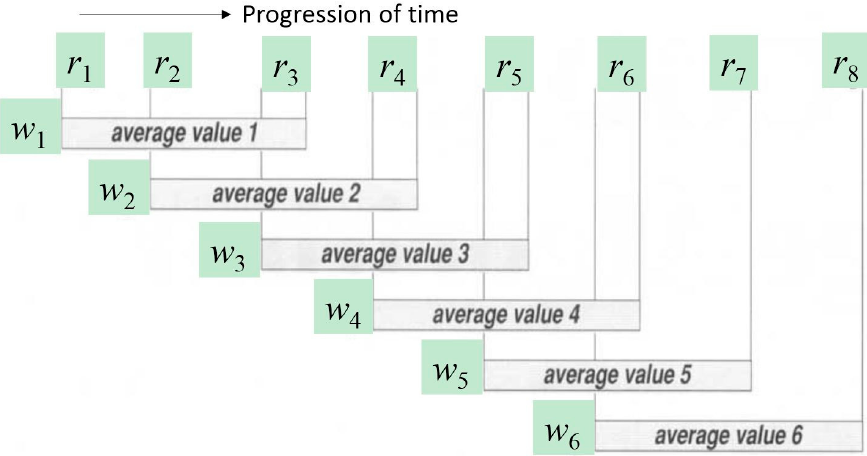
Figure 5. Snapshot of the moving average in action.